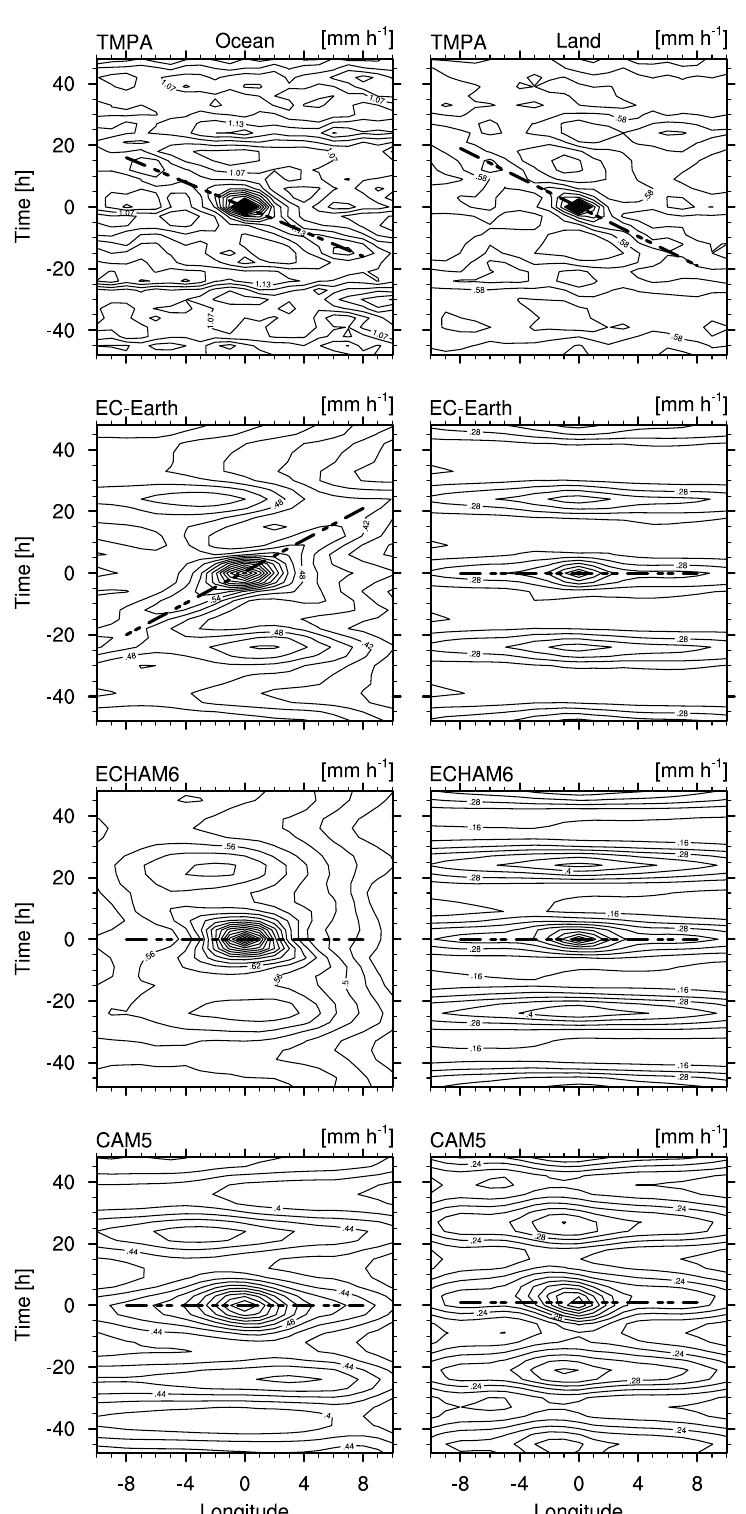
Figure 12. Hovmöller diagrams of rain rates centred on composite DC systems, for Tropical Rainfall Measuring Mission Multi-satellite Precipitation Analysis (TMPA), ECHAM6, CAM5, and EC-Earth3 for (left) ocean-based systems and (right) land-based systems. The lines drawn on the figures are visual aids indicating the various directions of zonal motion: eastward, westward, or stationary.